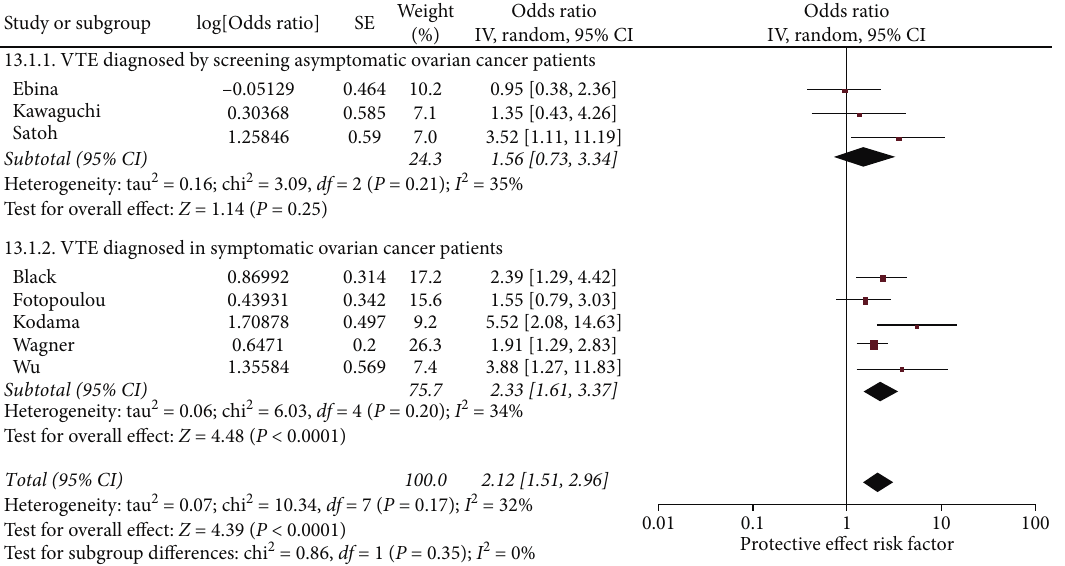
Figure 6: Forest plot of the odds of VTE in ovarian cancer patients that have ascites at diagnosis (versus nonsignificant ascites). This figure shows the pooled odd of ascites at diagnosis (versus nonsignificant ascites). The total pooled odds are 2.12 (1.51-2.96).